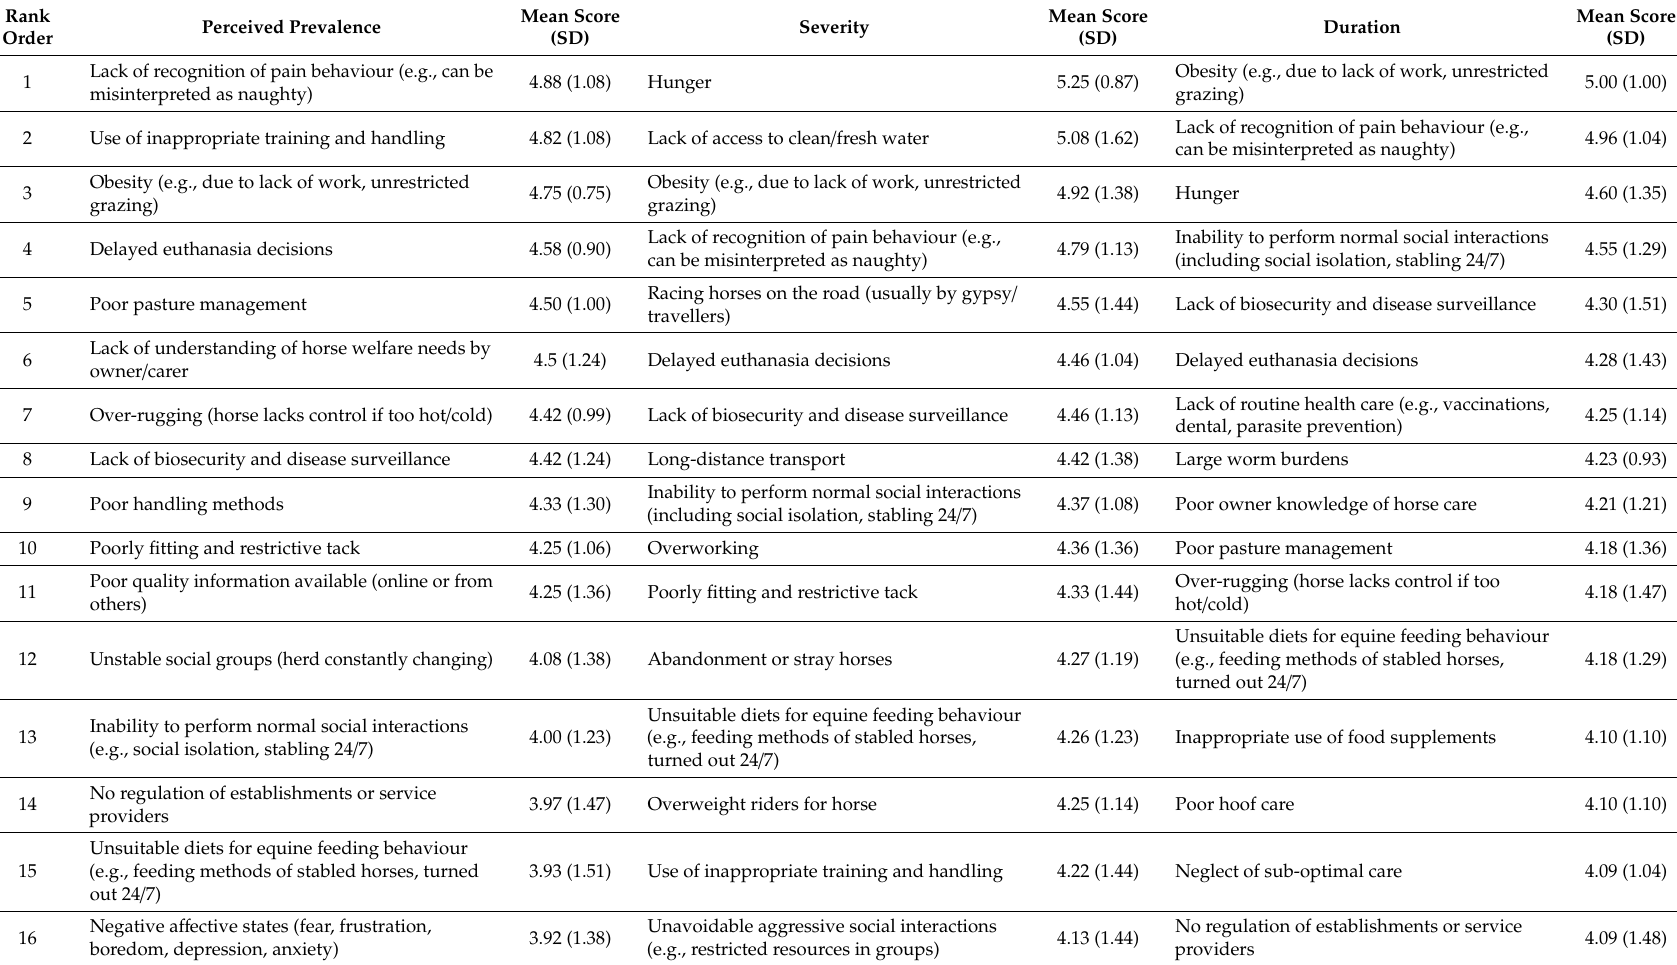
Table 2. Mean scores (with SD) and rank order for horse welfare issues that scored at least mean 3.0 or above for perceived prevalence, severity and duration of the welfare issue (issues scored using a Likert scale from 1–6, where 1 = never / none, and 6 = always /